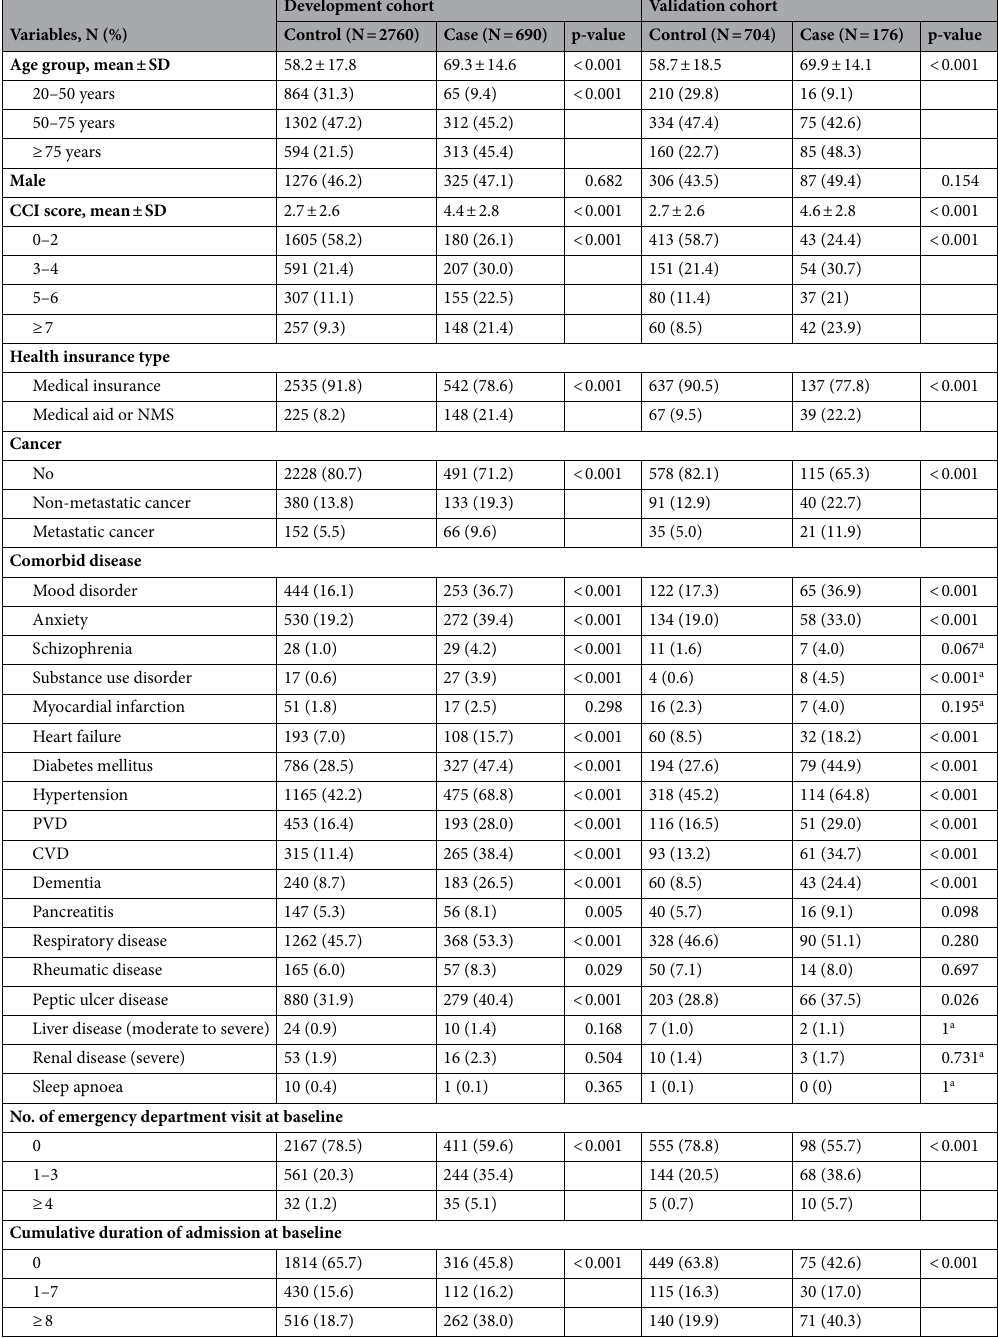
Table 1. Baseline characteristics of study participants according to outcomes in the development and validation cohorts. SD standard deviation, CCI Charlson comorbidity index, NMS National Meritorious Service, PVD peripheral vascular disease, CVD cerebrovascular disease. a Fisher’s exact